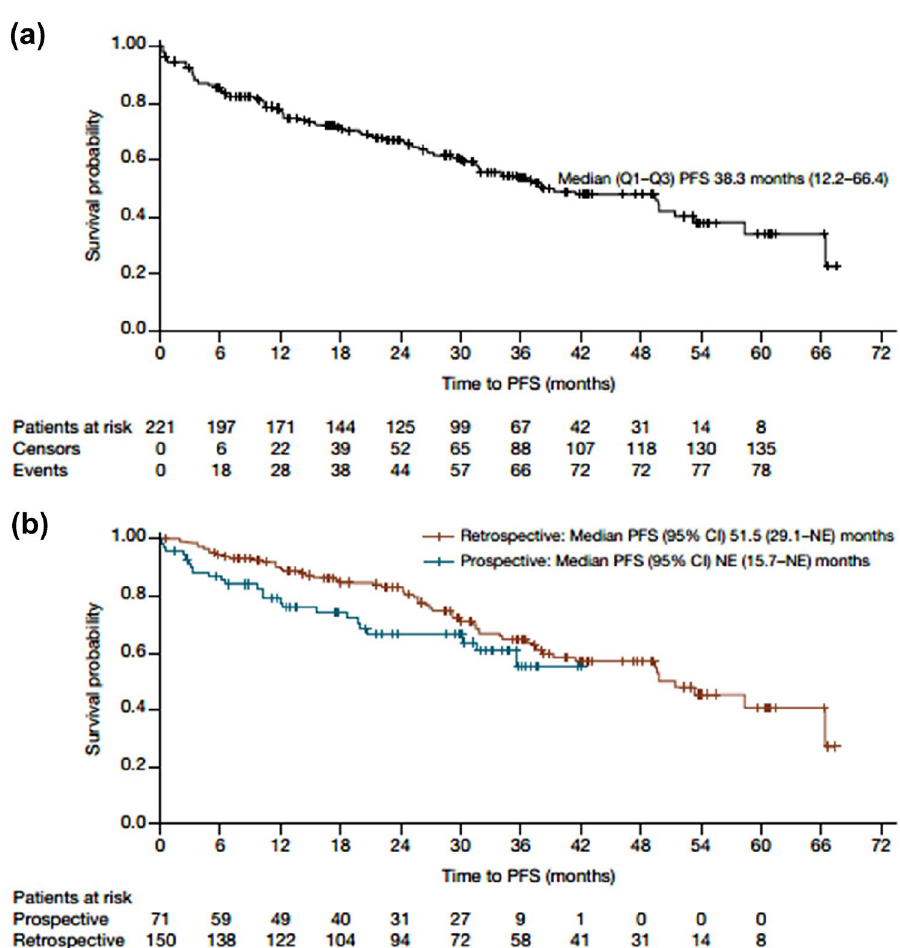
Fig. 1 a PFS for total popu- lation corrected with left trunca- tion. b PFS for prospective and retrospective